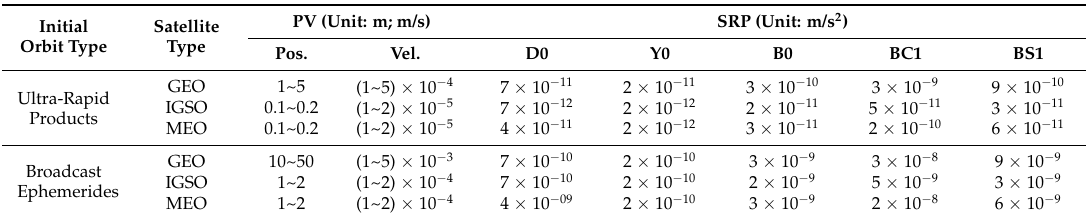
Table 12. The reference magnitude of a priori